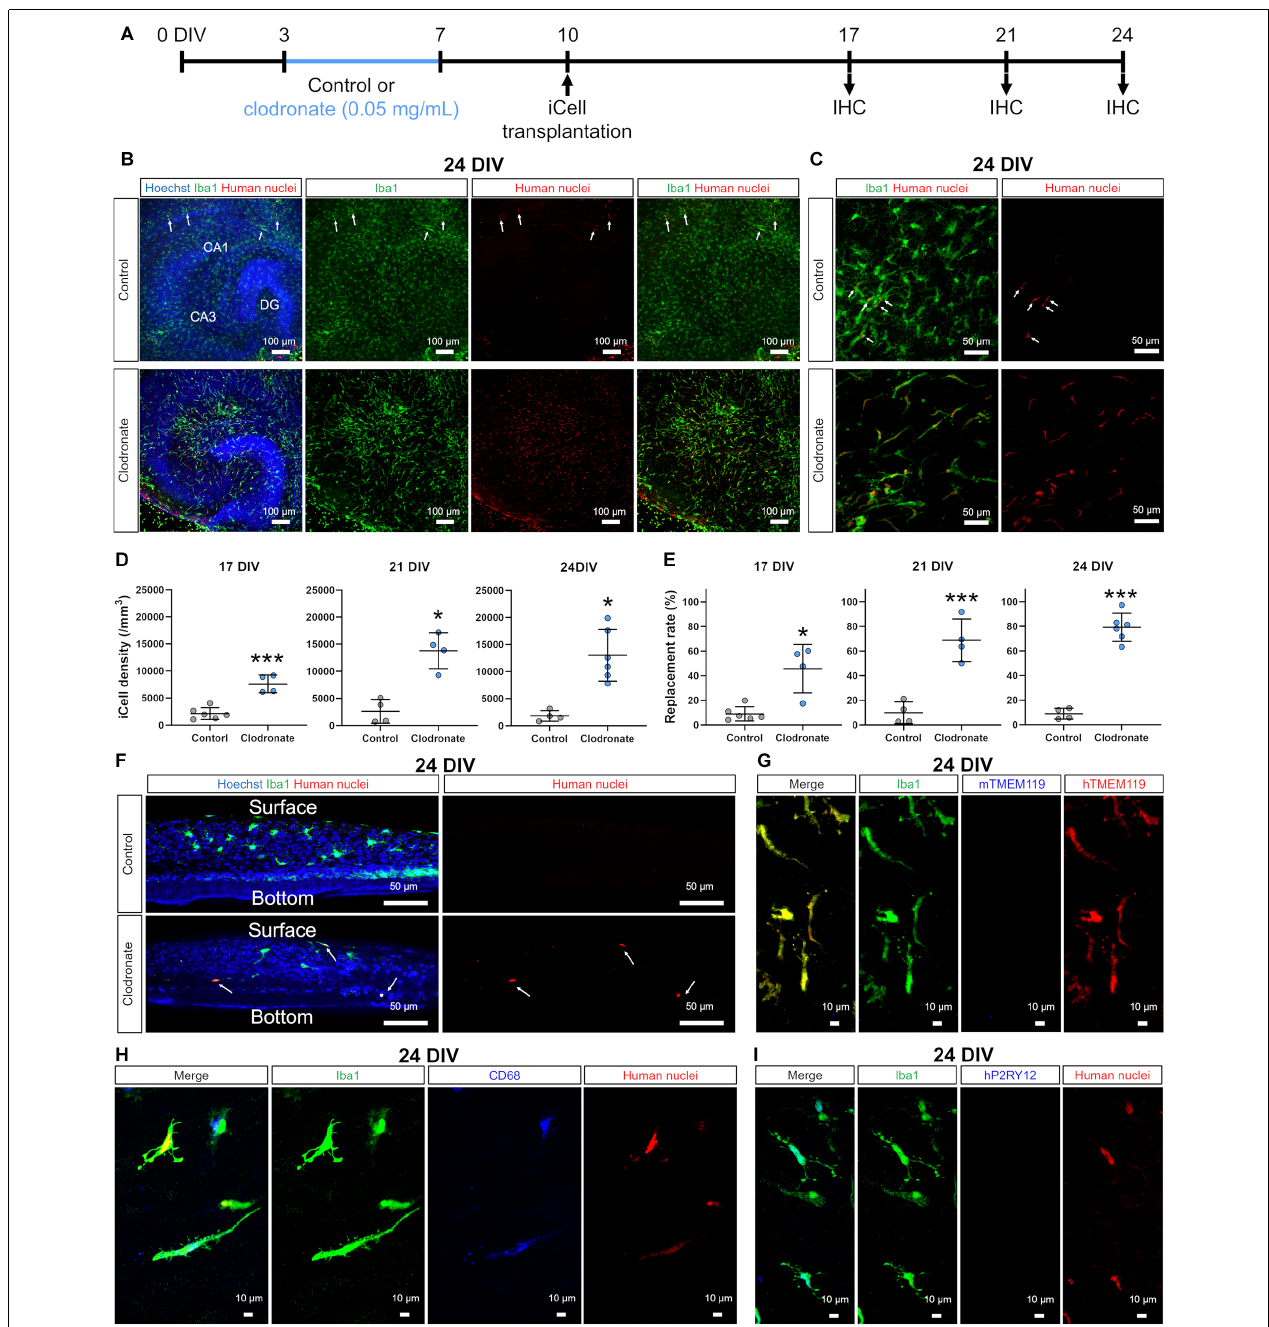
FIGURE 2 | Clodronate promoted the transplantation of iCell-MG in slice cultures. (A) Experimental paradigm. (B) Representative images of iCell-MG-transplanted slices at 24 DIV cultured with (lower) and without clodronate (upper, control). Cultures were immunostained for Iba1 (green) and human nuclei (red). Nuclei were stained with Hoechst (blue). (C) Magnified images of control (upper panels) and clodronate-treated slices (lower panels) at 24 DIV. (D) iCell-MG density at 17 (left panel), 21 (middle panel), and 24 DIV (right panel). *** p < 0.001 and * p < 0.05, Student’s t -test, n = 6 (17 DIV in control), four (17 DIV in clodronate), four (21 DIV in control), four (21 DIV in clodronate), four (24 DIV in control), and six slices (24 DIV in clodronate), each from two mice. Data represent the mean ± SD. (E) Replacement rate of iCell-MG at 17 (left panel), 21 (middle panel), and 24 DIV (right panel). * p < 0.05 and *** p < 0.001, Student’s t -test, n = 4–6 slices. Data represent the mean ± SD. (F) Representative images of innate and iCell microglial distribution at 24 DIV cultured with (lower) and without clodronate (upper, control). iCell-MG were distributed from the surface to near the bottom of slices (arrows). (G) Representative images of innate and iCell microglia at 24 DIV with clodronate. Cultures were immunostained for Iba1(green), mouse TMEM119 (mTMEM119; blue), and human TMEM119 (hTMEM119; red). (H) Representative images of innate and iCell microglia at 24 DIV with clodronate. Cultures were immunostained for Iba1 (green), CD68 (blue), and human nuclei (red). (I) Representative images of innate and iCell microglia at 24 DIV with clodronate. Cultures were immunostained for Iba1 (green), human P2RY12 (hP2RY12; blue), and human nuclei (red).